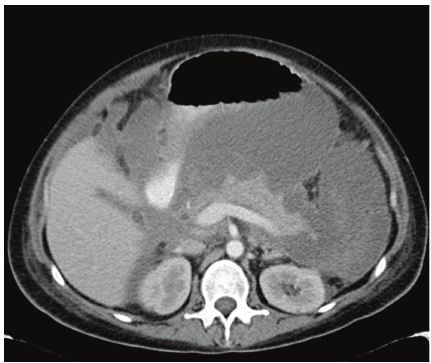
Figure 1: Axial contrast-enhanced CT abdomen 14 days after-ad- mission showing gross ascites and pancreatic parenchymal enhance-